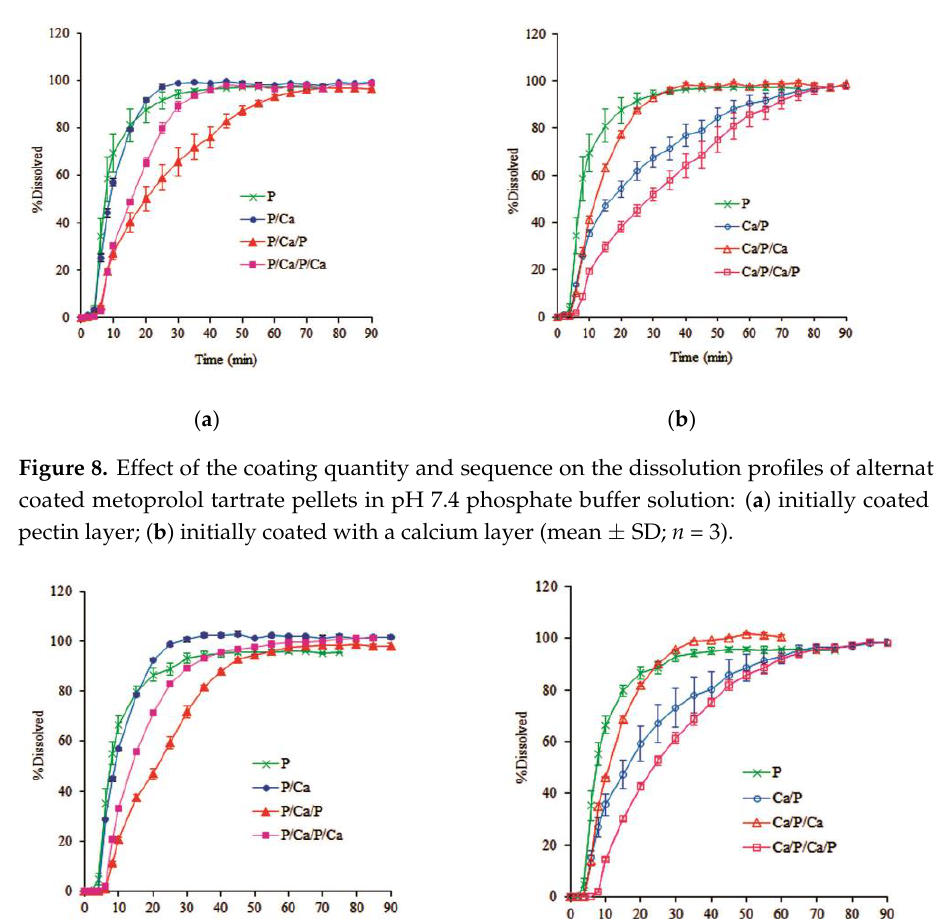
Figure 9. Effect of the coating quantity and sequence on the dissolution profiles of alternate layer